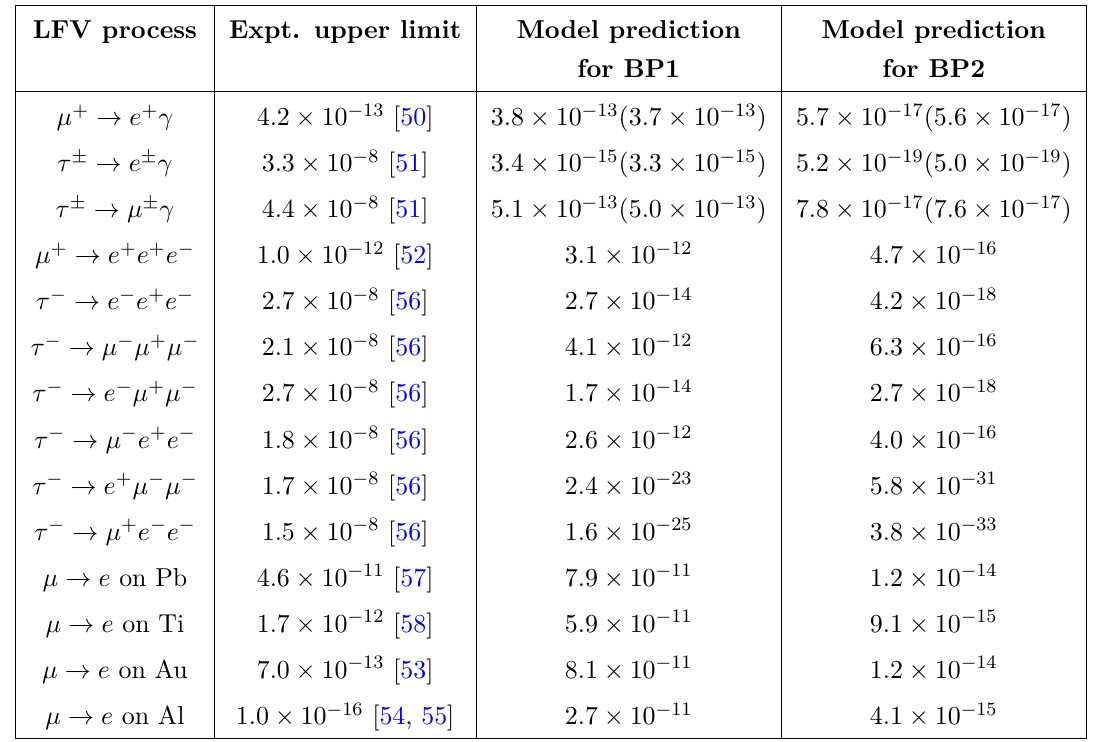
Table 2 . Experimental upper limit and model prediction for two benchmark points on the branch- ing ratio of various LFV processes. The last line in the table shows future sensitivity on µ → e conversion on Al. Bracketed values correspond to the branching ratio calculated using the analyti- cal expressions for ‘ α → ‘ β γ